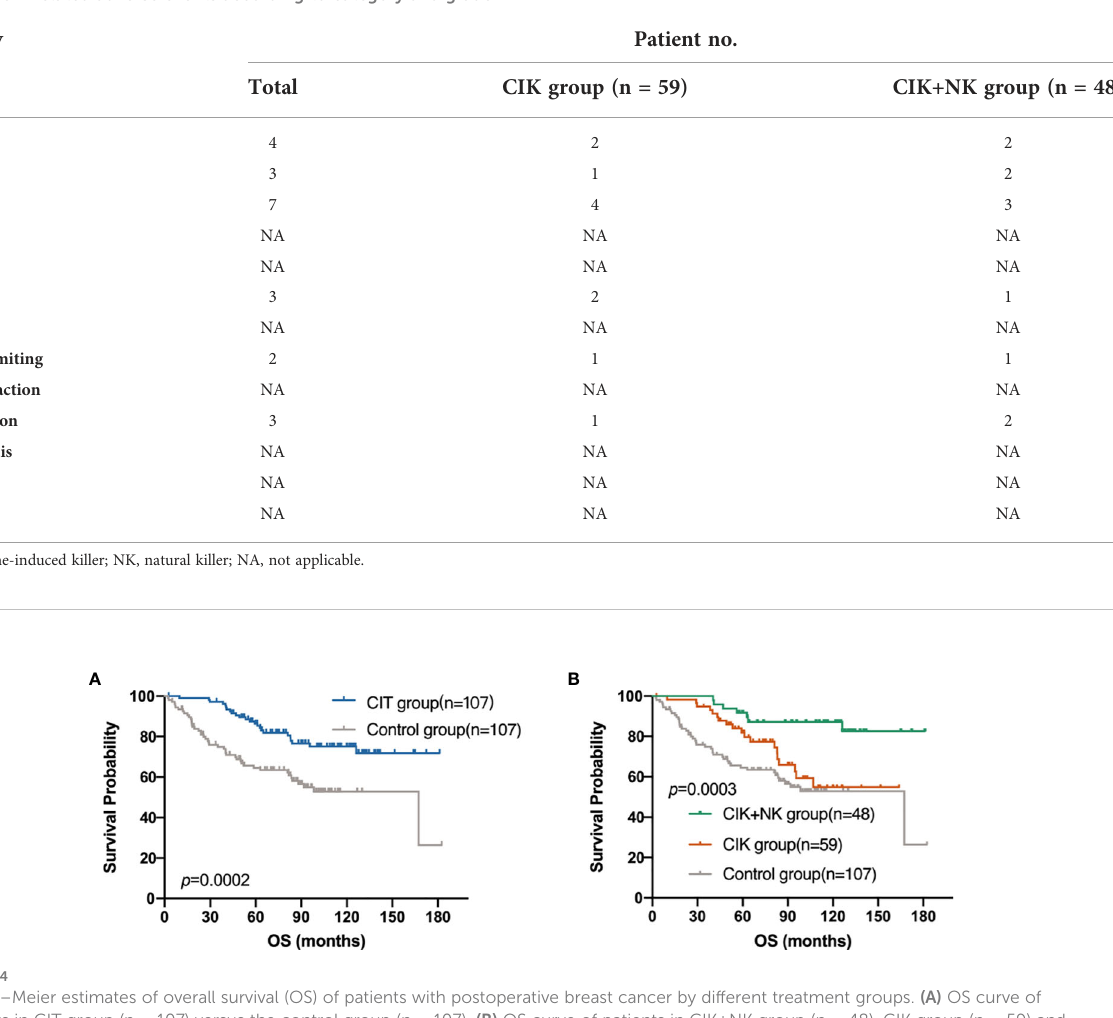
TABLE 3 CIT related adverse events according to category and grade.